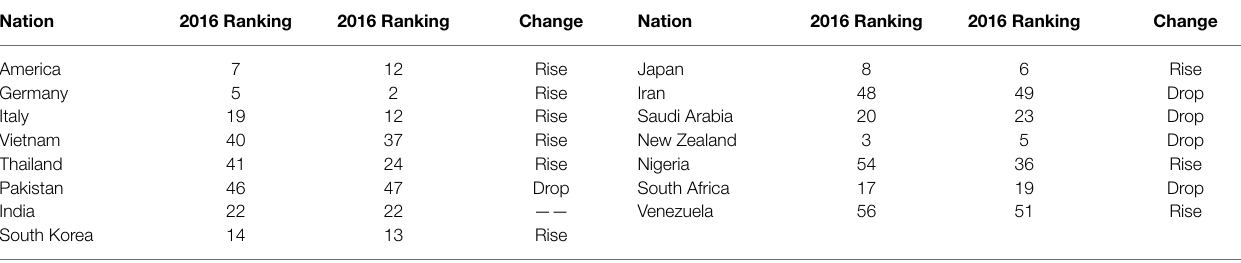
TABLE 10 | Changes in political risk in some of Haier’s overseas investment countries.